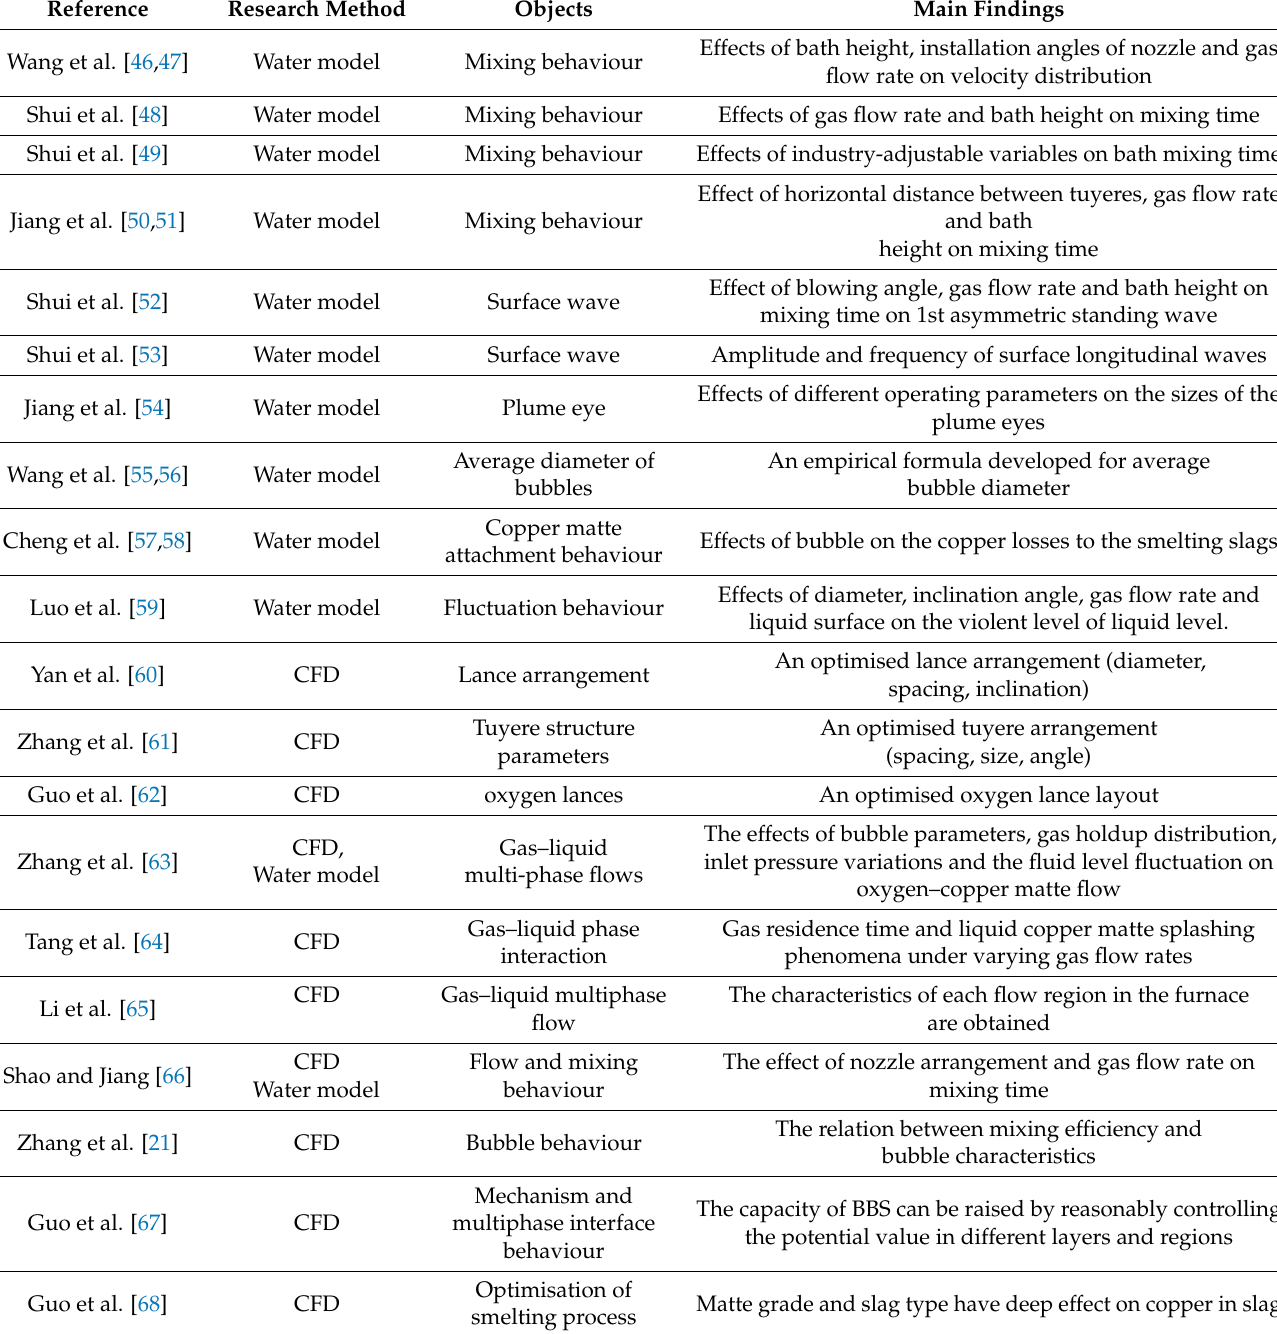
Table 4. Summary of the research on the fluid dynamic studies for the molten bath of